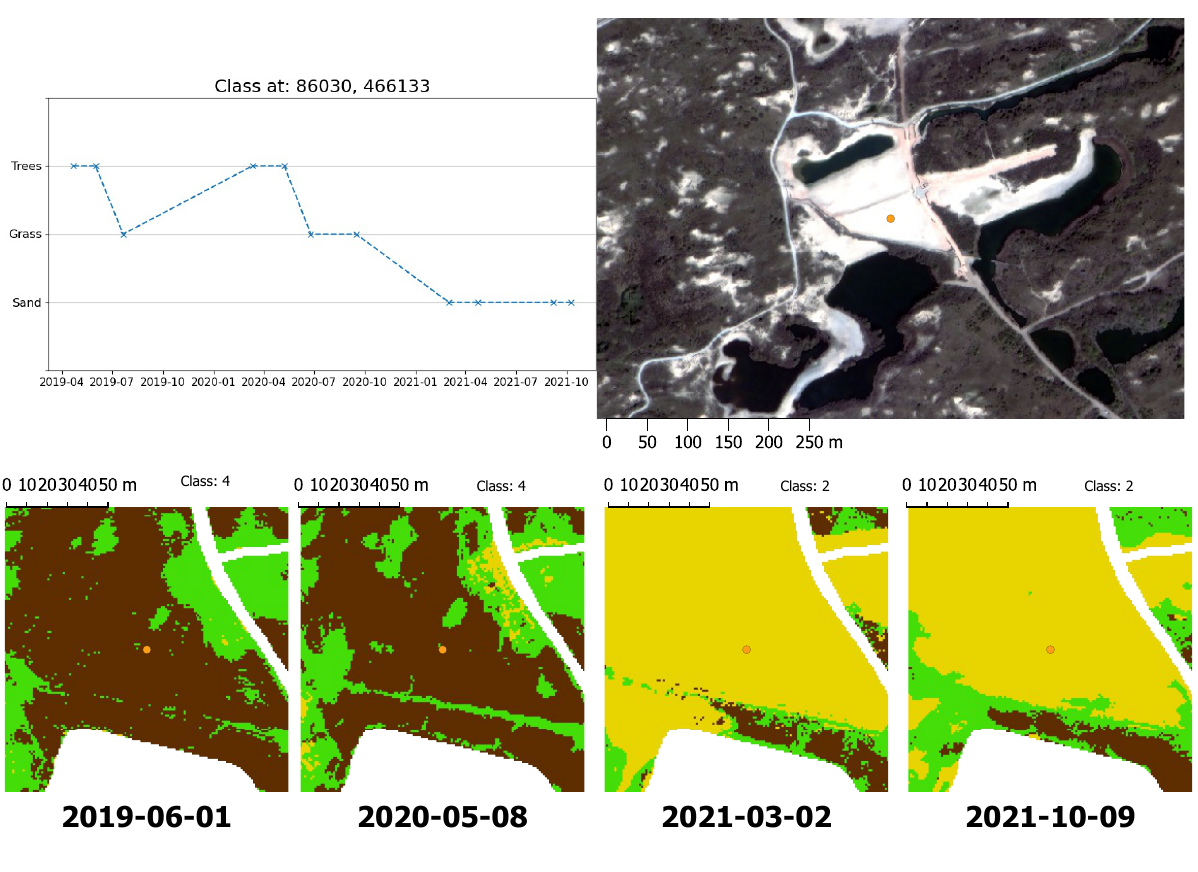
Figure 7. Classification results at and around a fixed point though time. The top right shows a recent areal photo with a query point indicated by a yellow dot. The graph at the top left shows the class predictions by the neural network for that location for each of the 11 Superview-1 images enriched with height. The pixel starts as Tree, changes to Grass and ends as Sand. The bottom row shows four classification results for different times, clearly demonstrating the transition from Trees to Sand for this case study